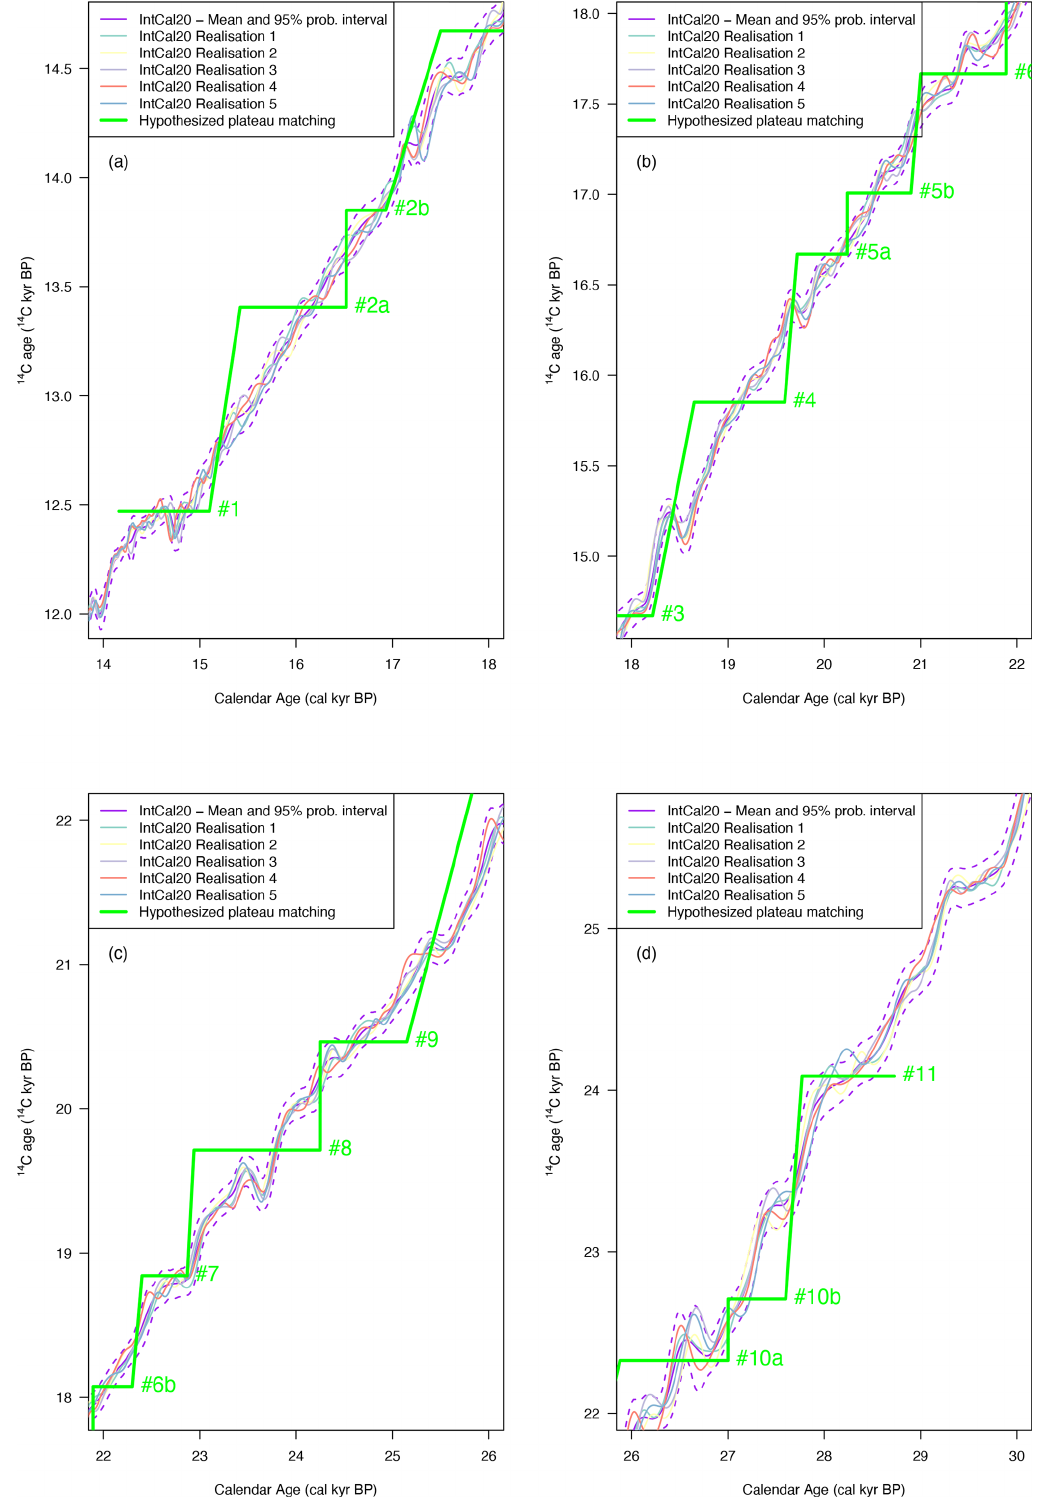
Figure 8. Plot of five individual spline realizations randomly selected from the Bayesian posterior of the Markov Chain–Monte Carlo approach used to create IntCal20. The published IntCal20 consists of pointwise means (shown as a solid purple line) and 95% pointwise predictive intervals (dotted purple line) that are obtained by averaging over 2500 of these individual curve realizations (Heaton et al., 2020b). Superimposed thick green lines indicate the 15 atmospheric plateaus with their numbering as listed in Table 1 of Sarnthein et al. (2020).